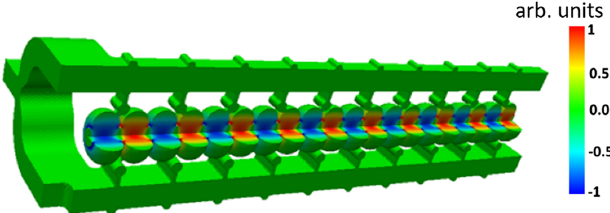
FIG. 12. Parallel feed of a 20-cell structure with large on-axis coupling. The contour plot is the Ez field, showing the π phase